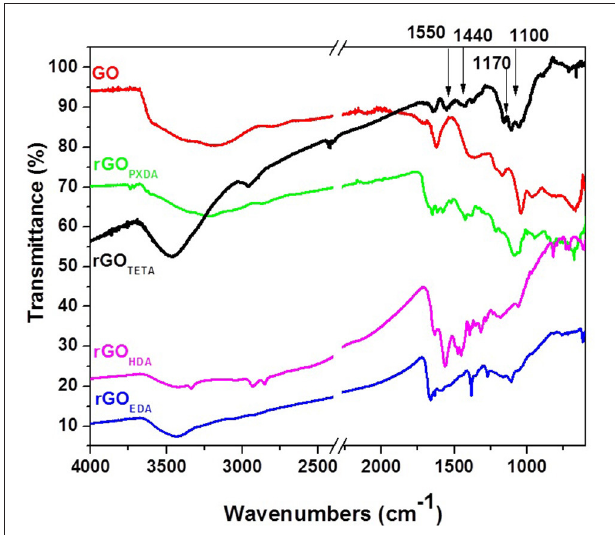
FIGURE 5 | FT-IR spectra of aerogels with aliphatic diamines.